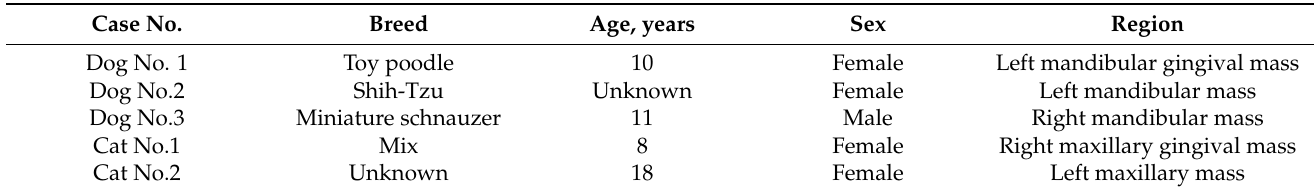
Table 1. Case information for dogs and cats included in the